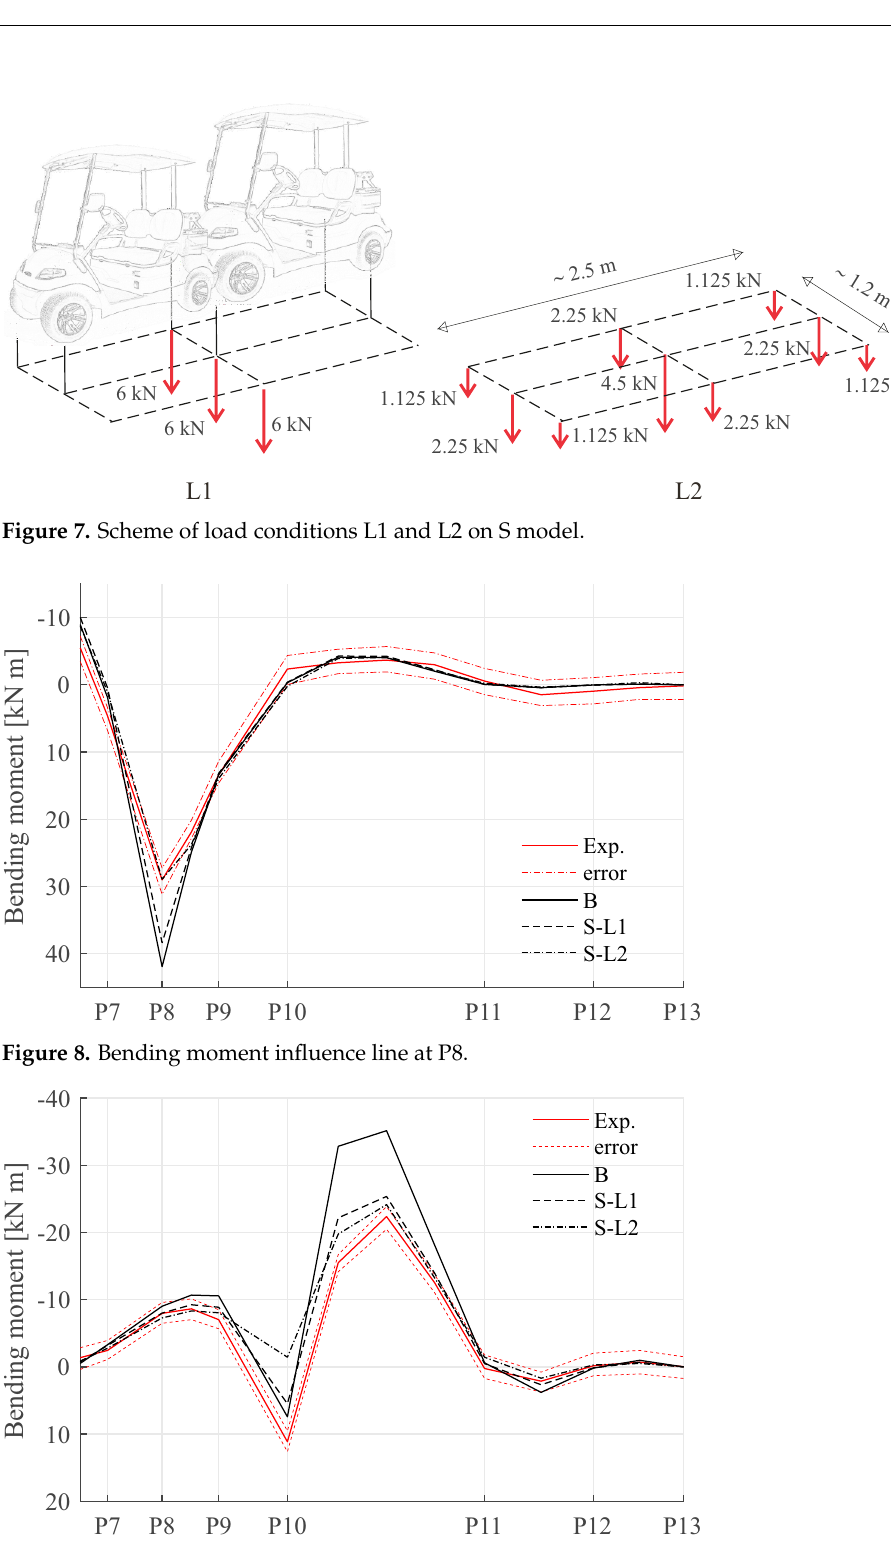
Figure 9. Bending moment influence line at